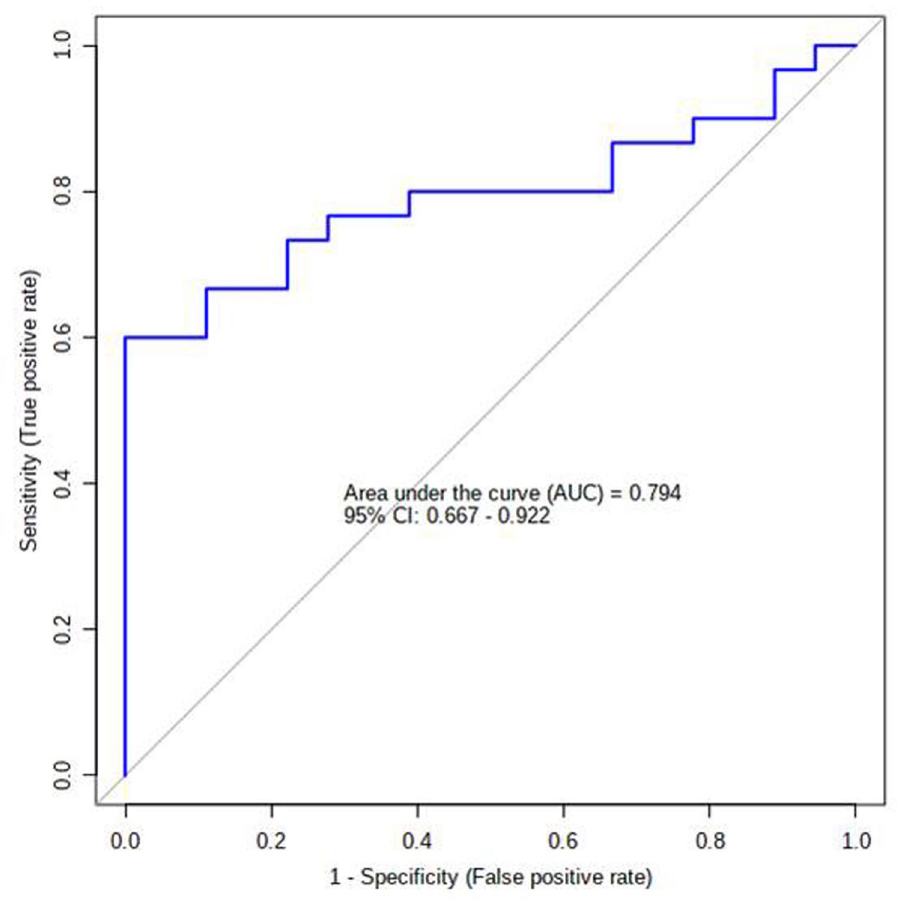
Figure 10. The performance of the logistic regression model constructed by using the combination of Anthranilate, 3-Hydroxykynurenine, and Tyrosine based on ROC AUC values along with with Sensitivity and Specificity at 95% CI in tenfold Cross